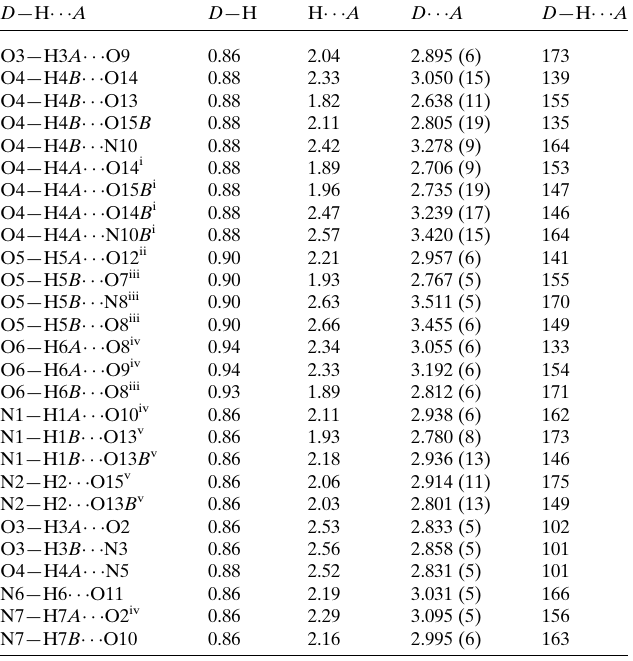
Table 1 Hydrogen-bond geometry (A˚ , (cid:4) ).